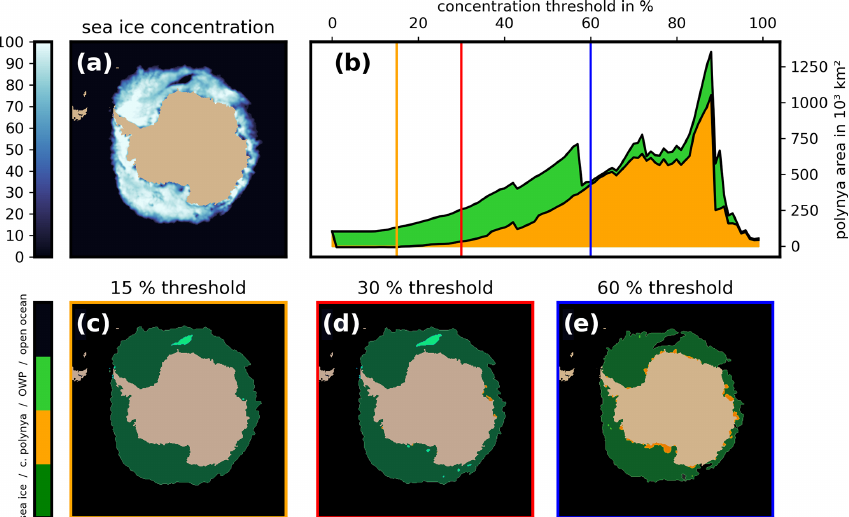
Figure 2. Illustration of the effect of different sea ice concentration thresholds on the detection of polynyas. (a) Observational sea ice concentration (OSI450) from 25 November 2017. (b) Combined area of coastal polynyas (orange) and OWPs (green) for sea ice concentration thresholds from 0% to 100%. The vertical lines correspond to the results of our algorithm for (c) 15%, (d) 30% and (e) 60% sea ice